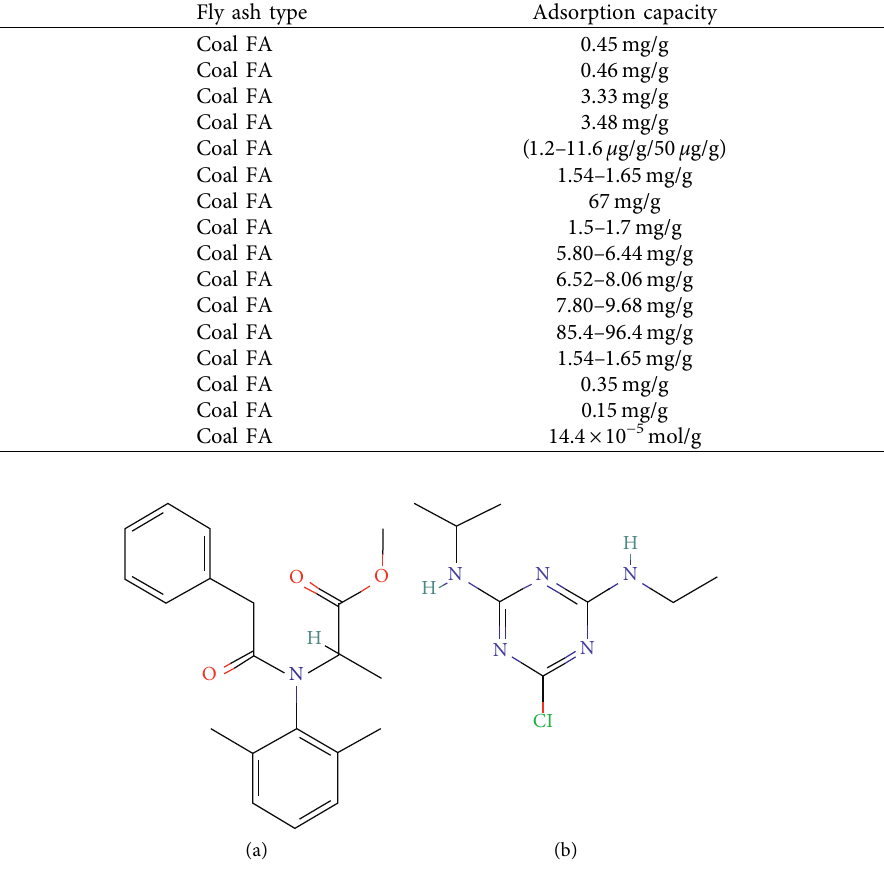
Figure 4: Structures of (a) benalaxyl and (b)